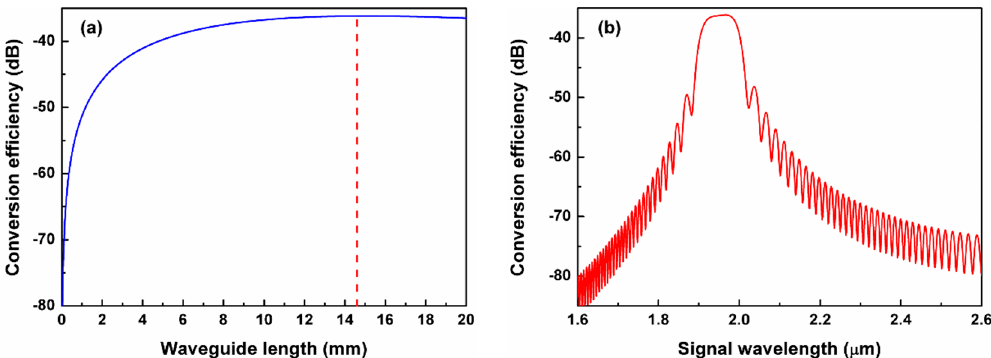
Figure 7. The calculated four-wave mixing conversion efficiency for the designed silicon-rich nitride ridge waveguide ( h = 700 nm, w = 1100 nm) with a maximal figure of merit (FOM). ( a ) Dependence on the waveguide length. Here, di ff erence of the pump and signal wavelengths is 1 nm. ( b ) Dependence on the signal wavelength. Here, the waveguide length is 14.6 mm and the pump wavelength is 1950 nm.